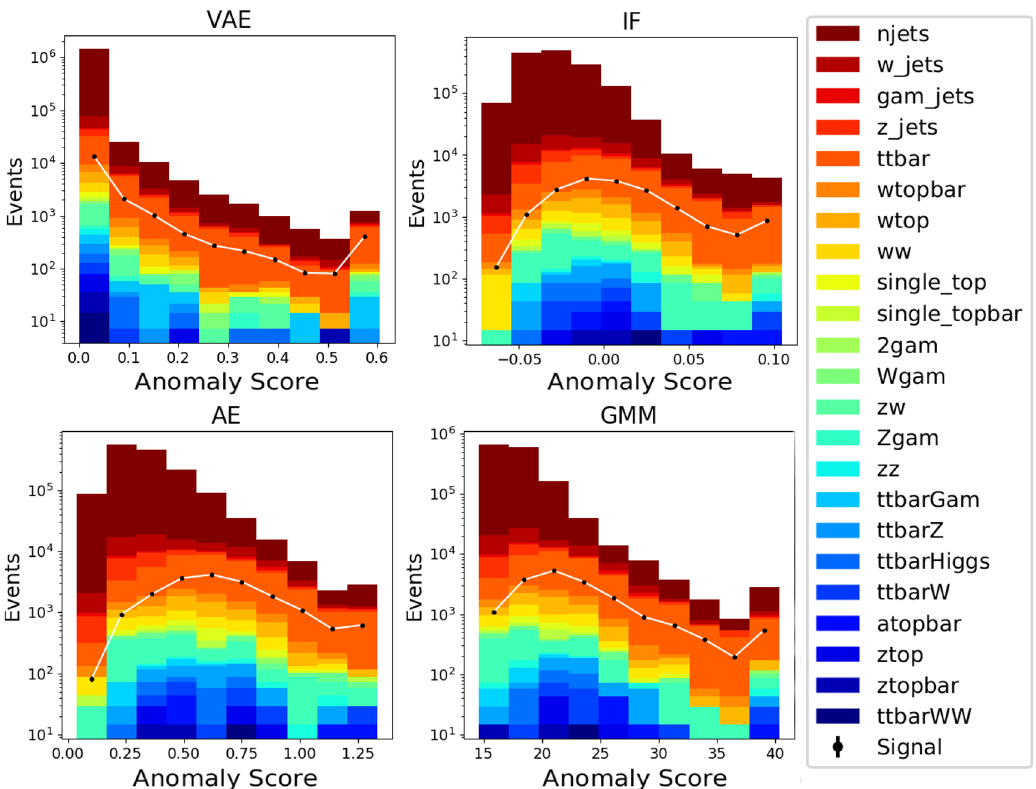
Figure 10 . Anomaly score histograms derived from various algorithms for Stop